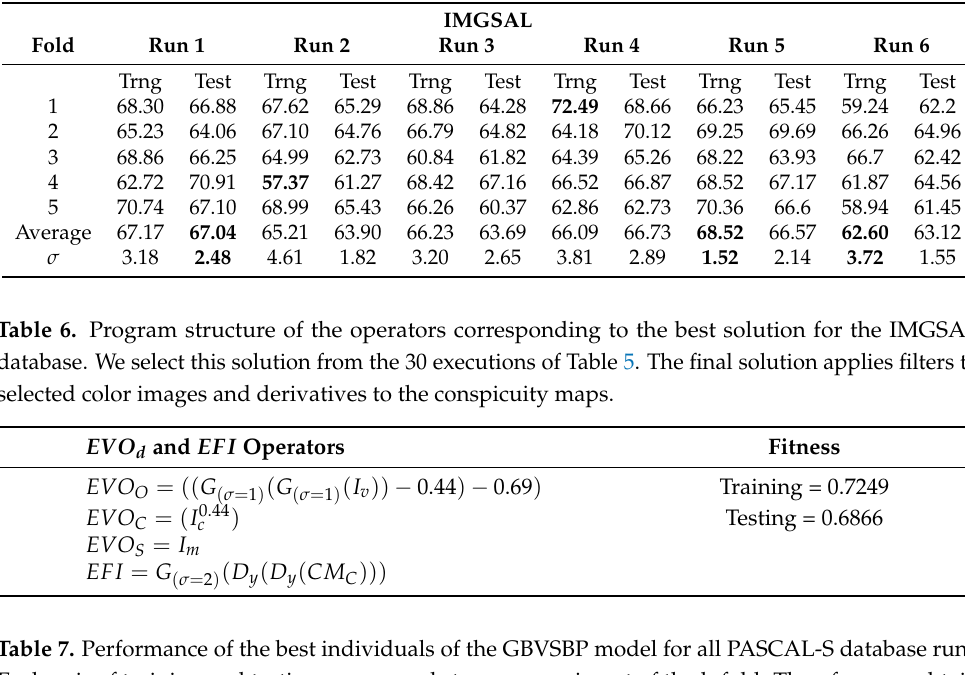
Table 5. Performance of the best individuals of the GBVSBP model for all IMGSAL database runs. Each pair of training and testing corresponds to one experiment of the k-fold. Therefore, we obtain 30 executions of our system and report the standard deviation for each run set.